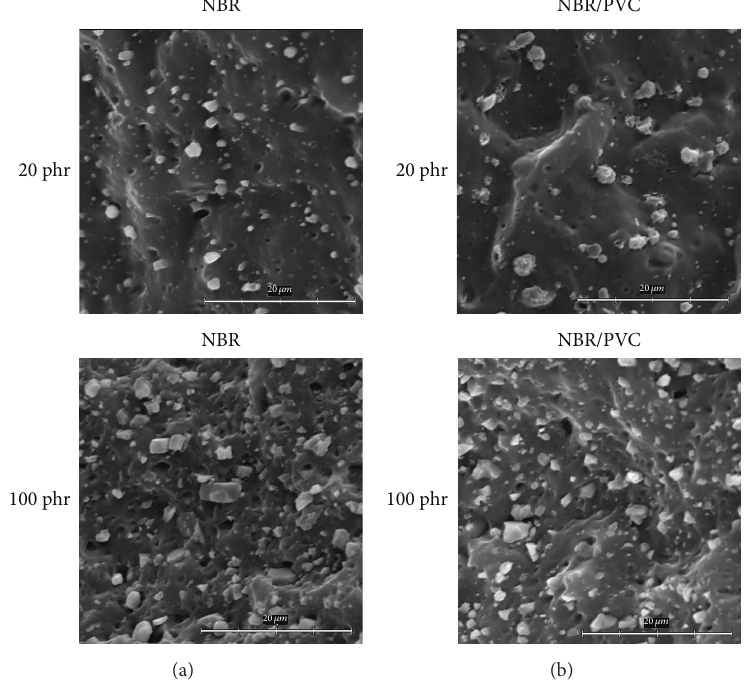
Figure 12: SEM images of